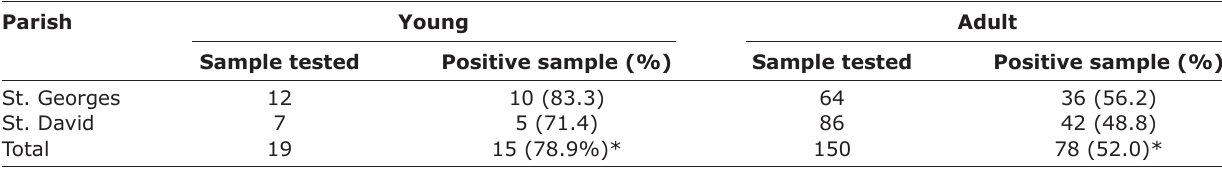
Table-3: Prevalence of Giardia antibody (anti-GD) in serum of brown rats from Grenada according to age. Parish